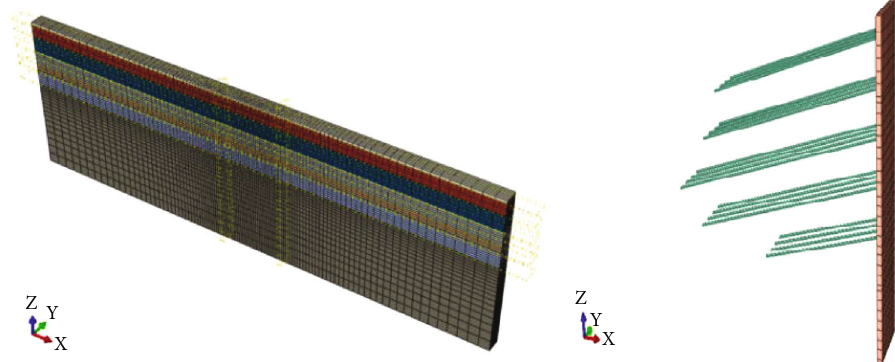
Figure 4: 3D numerical